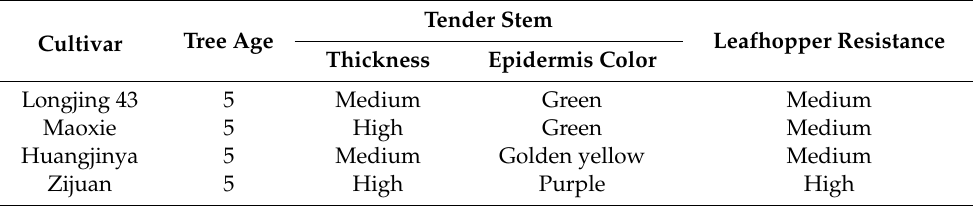
Table 1. Varietal characteristics of the four chosen tea